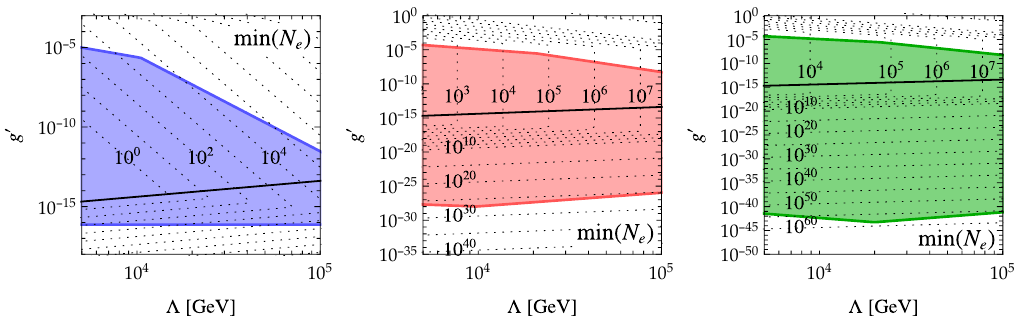
Figure 3 . Minimal number of efolds in the scenario where relaxation takes place during an in(cid:13)ation era for the three stopping mechanisms discussed in section 3.1. Same color code as in (cid:12)gure 2. Below the solid line the (cid:12)eld excursion (cid:3) =g 0 is